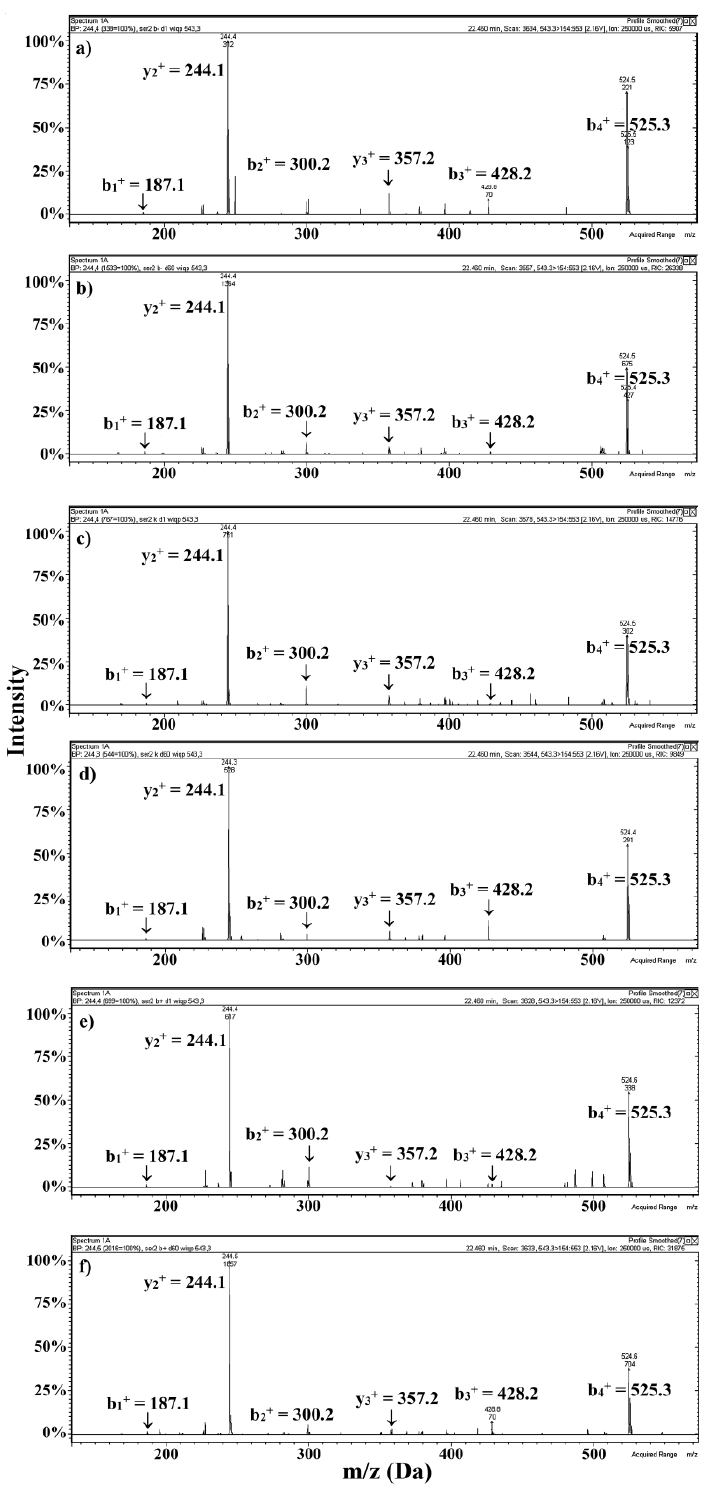
Figure 3. MS/MS spectra of the WIQP DPP-IV inhibitory peptide identified in the water-soluble extracts of the Gouda cheese. Nomenclature of daughter ions according to Roepstorff and Fohlman [52]. Samples derived from: ChCN ↓ -1 ( a ), ChCN ↓ -60 ( b ), ChCN-0-1 ( c ), ChCN-0-60 ( d ), ChCN ↑ -1 ( e ), ChCN ↑ -60 ( f ), respectively. Abbreviations: ChCN ↓ -1, ChCN ↓ -60, ChCN-0-1, ChCN-0-60, ChCN ↑ -1, ChCN ↑ -60—water-soluble extracts derived from Gouda cheese with: reduced ( ↓ ), normative (0), and increased ( ↑ ) content of β-casein after 1 (suffix 1) and 60 (suffix 60) days of ripening, respectively.